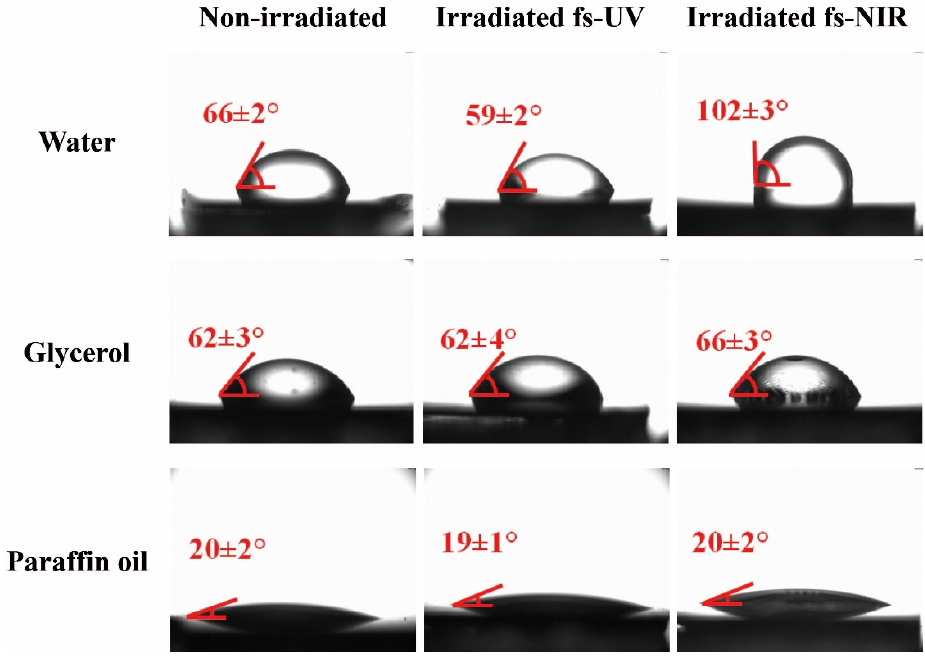
Figure 5. Images of droplets from three different test liquids on unirradiated and irradiated surfaces with fs UV and fs NIR pulses of PET/EG 0.4 wt.%. In all images, the values of the corresponding contact angle between the drop of the test liquid and the surface are indicated. Table 2. Contact angles of the different probe liquids (water, glycerol, and paraffin ‐ oil) of non ‐ irra ‐ diated (NI) and irradiated (fs UV and fs NIR pulses) on PET and PET/EG 0.4 wt.% surfaces, obtained by the sessile drop technique. The data listed correspond to the average and standard deviation of three different measurements.